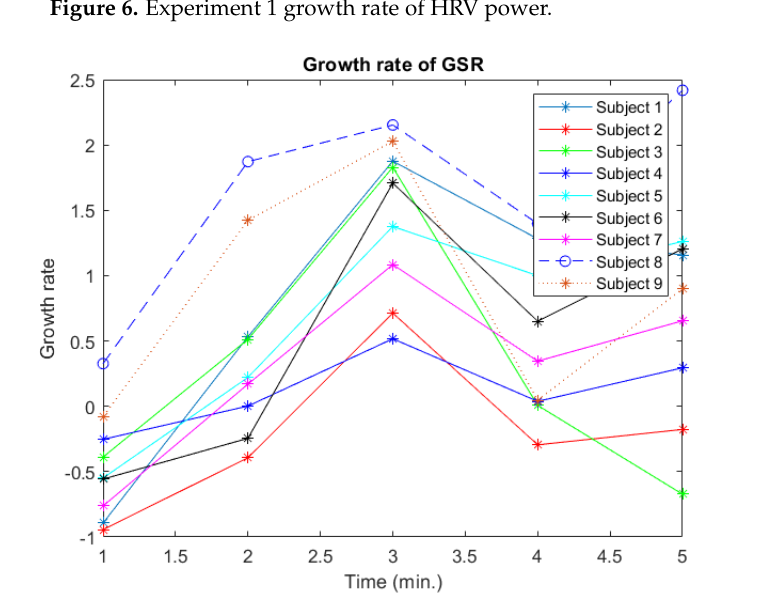
Figure 7. Experiment 1 growth rate of